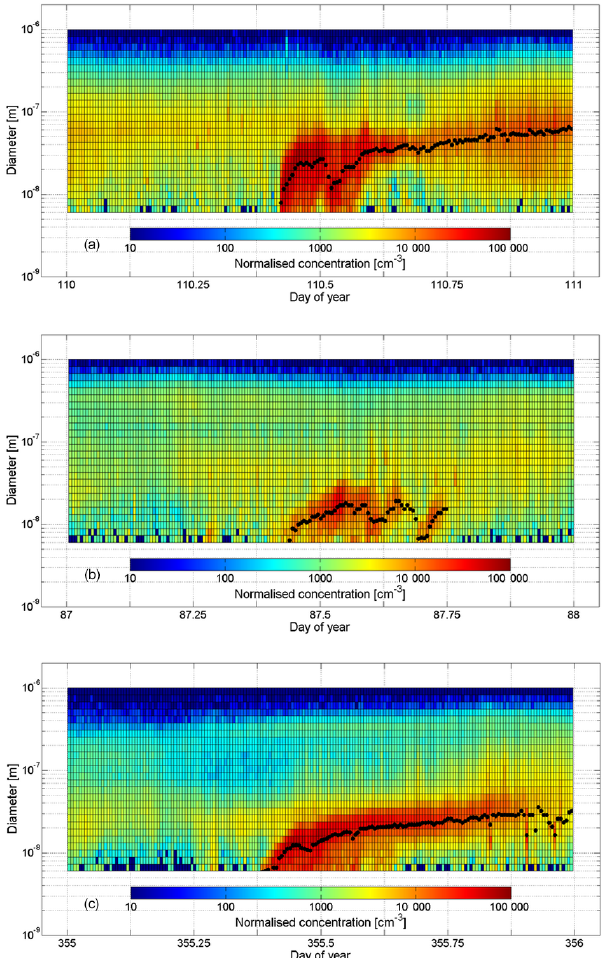
Figure 9. Size distribution surface plots for NPF and consecutive particle growth as banana-shaped plot with double onset (a) in the city centre on Sunday, 20 April 2014, with multiple onsets (b) in the city centre on Saturday, 28 March 2015, and with a broad con- tinuous onset (c) in the city centre on Sunday, 21 December 2014. Time series of the fitted particle number median mobility diameter for the nucleation mode are indicated by black dots on each